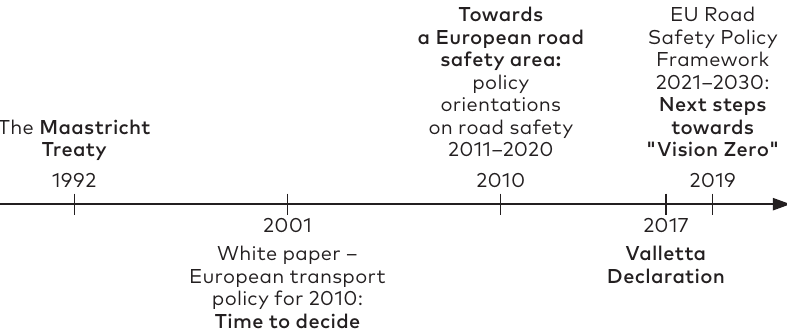
Figure 1. Chronology of the EU acts for road